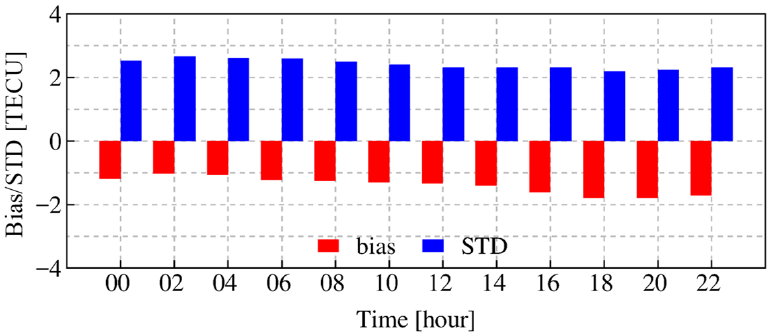
Figure 7. Statistical results of NeQuick2 model with respect to IGSG every two hours.